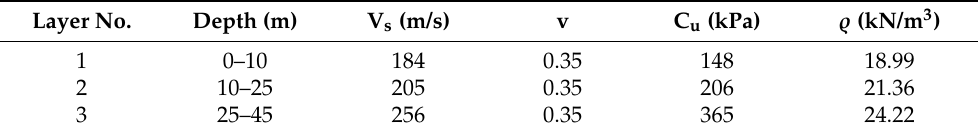
Table 4. Geotechnical characteristic of the soil